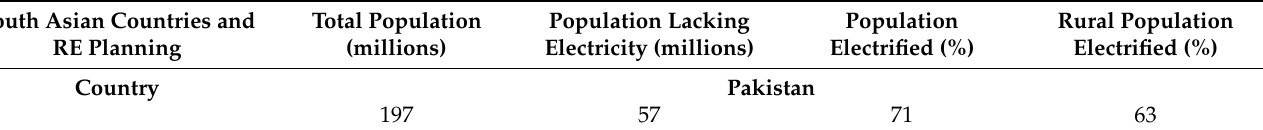
Table 3. Current and prospective energy statistics of South Asian